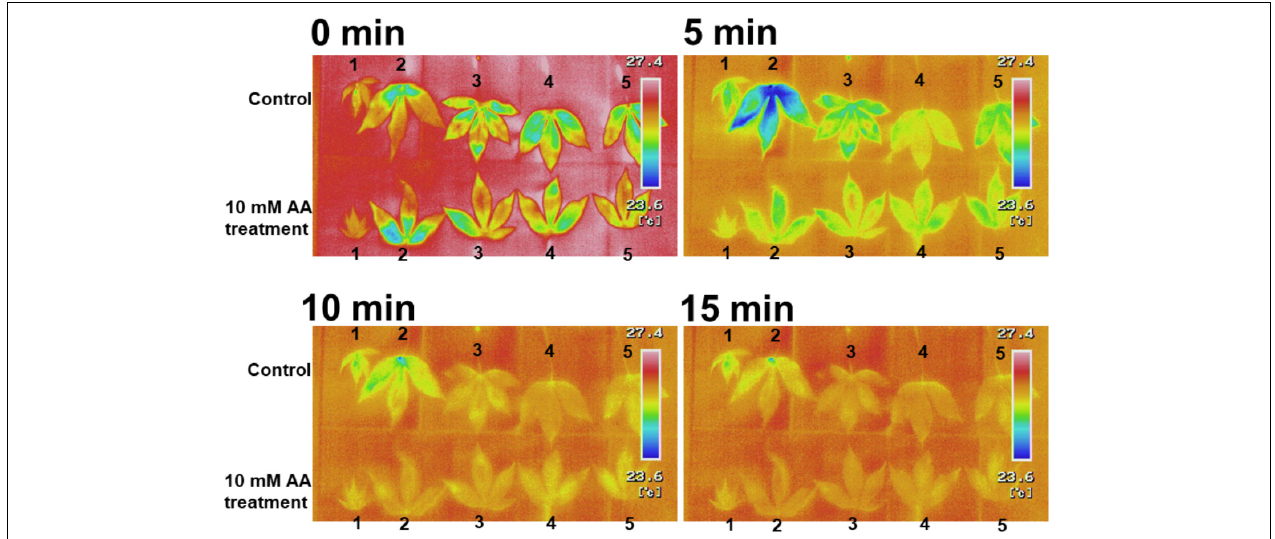
FIGURE 3 | Thermal images of detached leaves from cassava plants treated with 10 mM acetic acid or water (control). Cassava plants were treated with 10 mM acetic acid or water for 7 days. The first six leaves from the top stem were removed and the leaf temperature was measured at 0, 5, 10, and 15 min after leaf